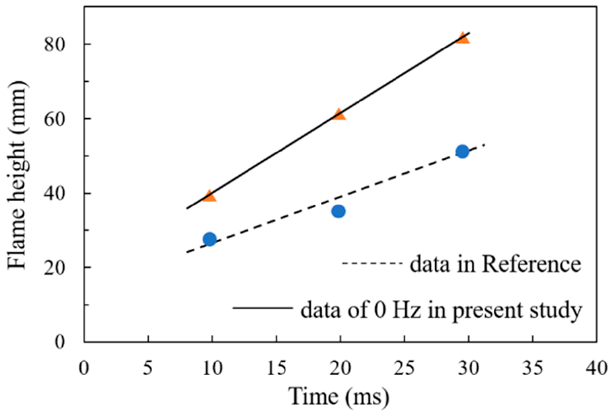
Figure 6. The comparison of experimental data with similar test conditions [35].